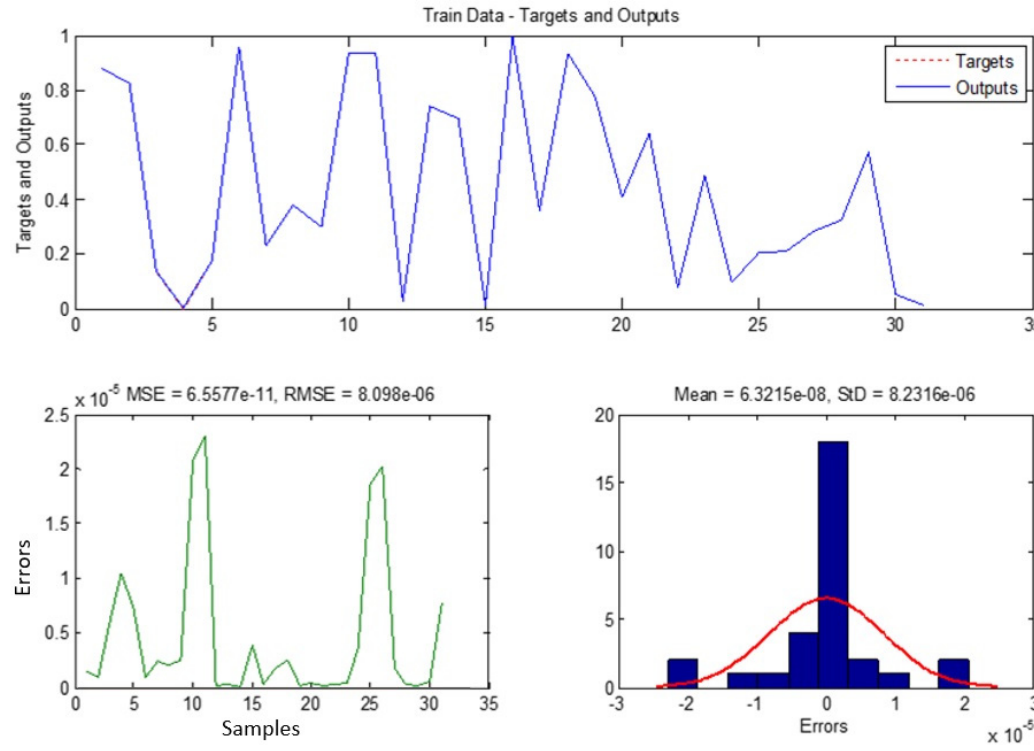
Figure 5. Model performance criteria for training data.